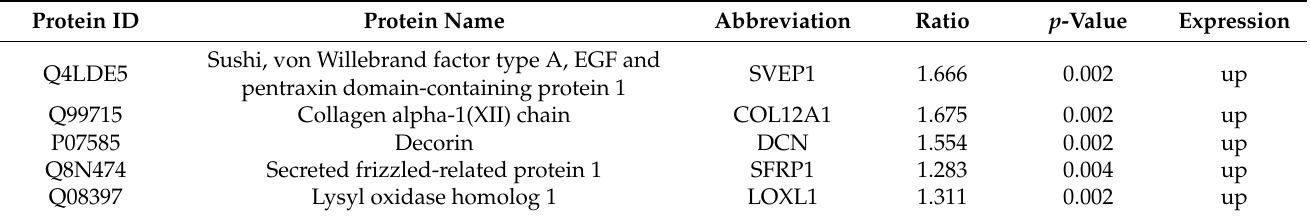
Figure 5. Exosomal protein identification via iTRAQ-based proteomic analysis. ( a ) Venn diagrams showed that 1792 proteins were identified from the Hypo-Exos samples, among which 1506 proteins overlap with that reported in ExoCarta (http://exocarta.org/, accessed on 1 July 2021). Seventy-nine differentially-expressed proteins (DEPs) were identified, and 70 were found in the ExoCarta database. ( b ) GO annotation analysis of 1792 exosomal proteins via Blast2go. Proteins were classified by cellular component, molecular function, and biological process. ( c ) Volcano plot representing the fold change and p -value in Hypo-Exos and Nor-Exos. x-Axis showed fold change, while y -axis depicted p -value. Red for upregulated proteins, green for downregulated proteins, gray for no significant expressed proteins. ( d ) GO Biological process of DEPs in Hypo-Exos vs. Nor-Exos. ( e ) KEGG pathway analysis of DEPs in Hypo-Exos vs. Nor-Exos. Table 1. 79 proteins were differentially-expressed between Hypo-Exos and